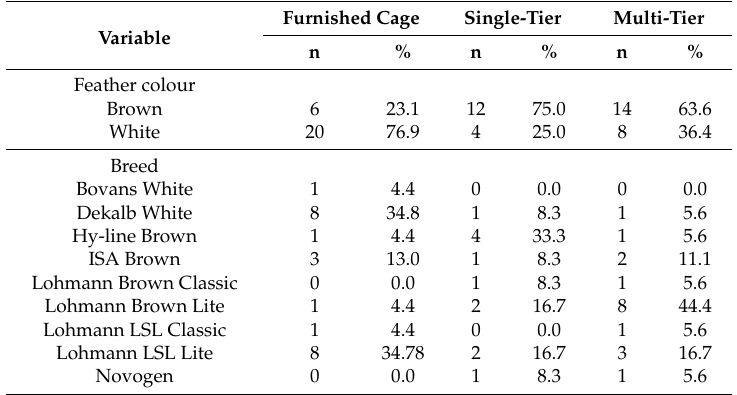
Table 6. Frequency of flock characteristics for 65 laying hen flocks placed between October 2016 and December 2017 according to housing system (furnished cage n = 26, single-tier n = 17, multi-tier n = 22) in Canada.